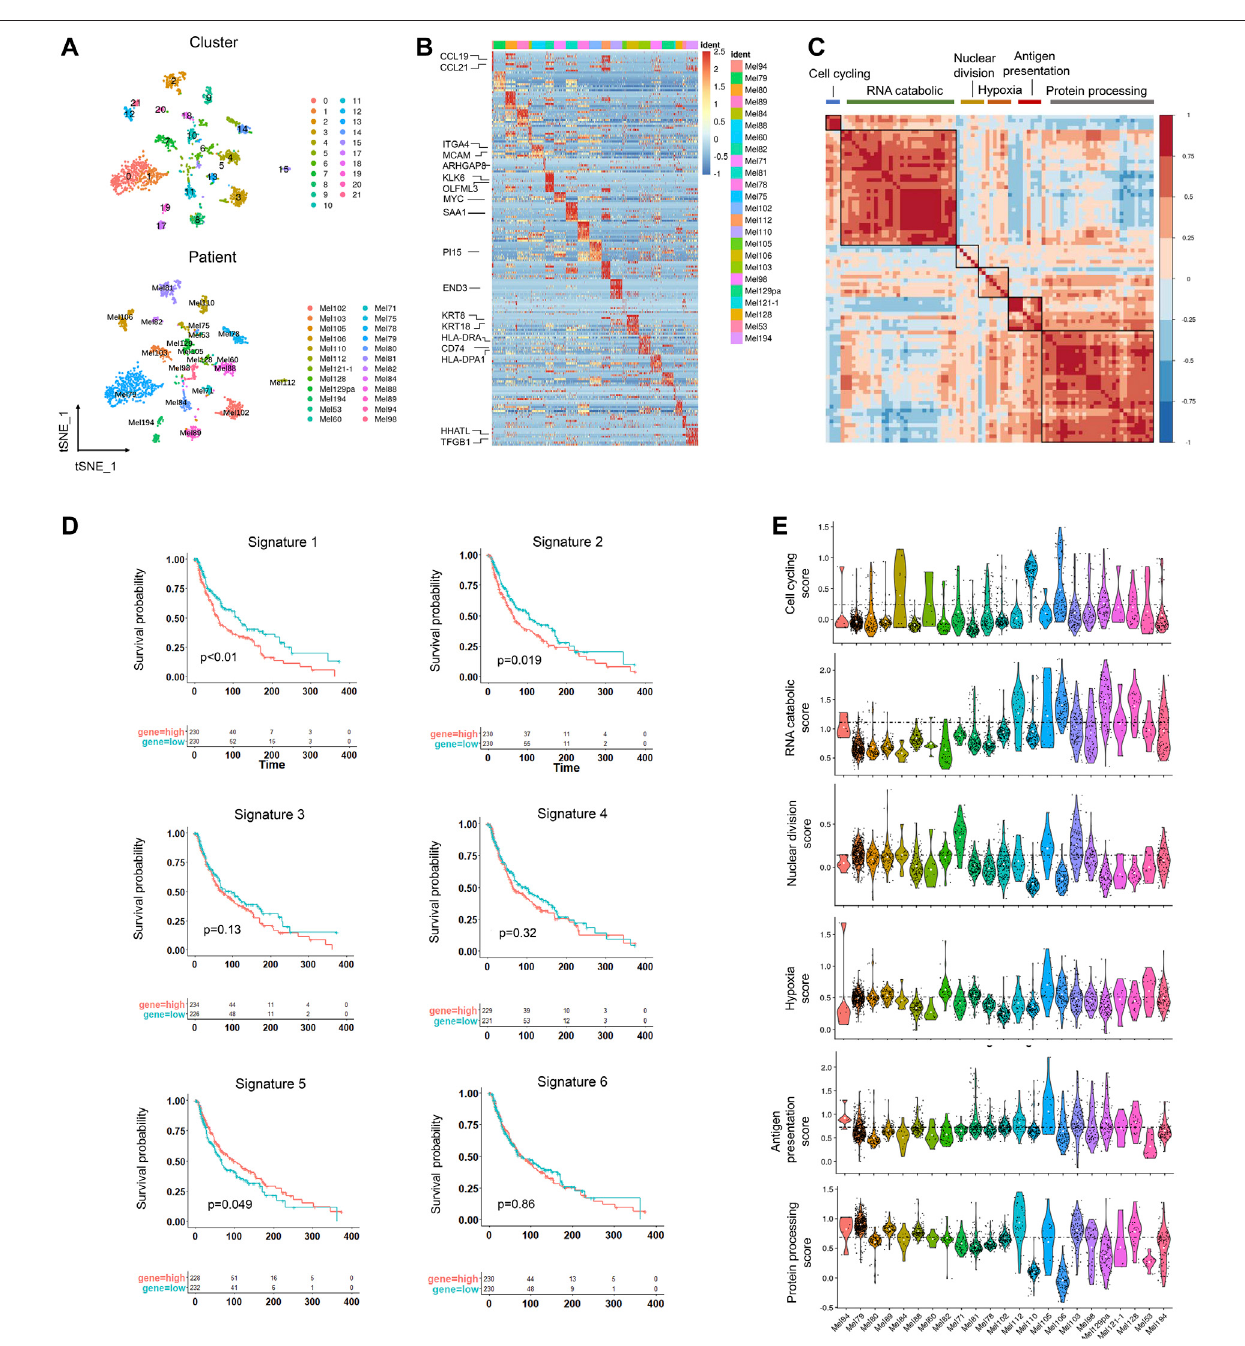
FIGURE2| Inter-tumoral and intra-tumoral heterogeneity inmelanomatumor cells. (A) UMAP plot of2089malignantcells colored byclusters(upper)and patients (lower). (B) Heatmap showing the marker genes (rows) that are differentially expressed across individual tumors (columns), and selected genes are highlighted. The differentially expressed geneswerecalculatedbythe “ FindAllmarkers ” functionintheSeurat package(logFC > 0.25).Thecoloroftheheatmaprepresentsthelogarithmic scaled expression level of the genes. (C) Heatmap showing the pairwise correlations of metagenes derived from 22 tumors. Clustering identi fi ed six coherent malignant gene expression signatures across the tumors. (D) Kaplan – Meier curves for progression-free survival in the 460 patients in TCGA SKCM cohort according to high vs. low expression of the signature score evaluated by ssGSEA. The corresponding Cox regression p value is also shown. (E) . Violin plot showing the signature scores for one of the six malignant signatures for malignant cells from the 22 tumors.